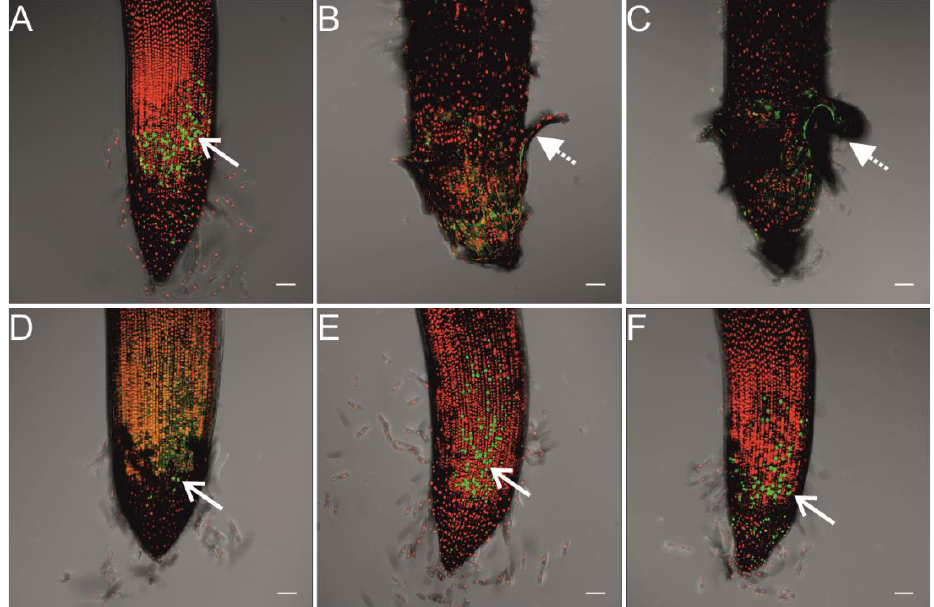
Figure 4 . Fluorescence images of a live/dead assay of the wheat root tips after 3 days of seedling development in Ag NPs with sizes of 0 ( A ), 10 ( B ), 20 ( C ), 40 ( D ), 60 ( E ), and 100 nm ( F ). Syto9 green fluorescence is characteristic for viable cells and nonviable cells, and PI red fluorescence is characteristic for nonviable cells only. Scale: the length of the horizontal white bars equals 100 µm. In seedlings treated with 10 and 20 nm Ag NPs, more dead than live cells were localized in the root apical region ( B , C ), dotted arrows with a higher level of ROS generation (Figure 3B,C, dotted arrows).